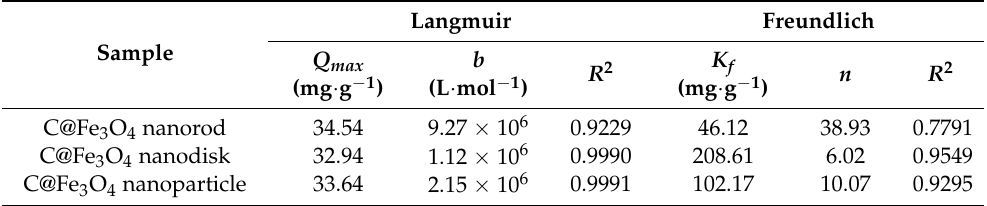
Table 3. Langmuir and Freundlich parameters for MB adsorption on three C@Fe 3 O 4 composites nanorod, nanodisk, and